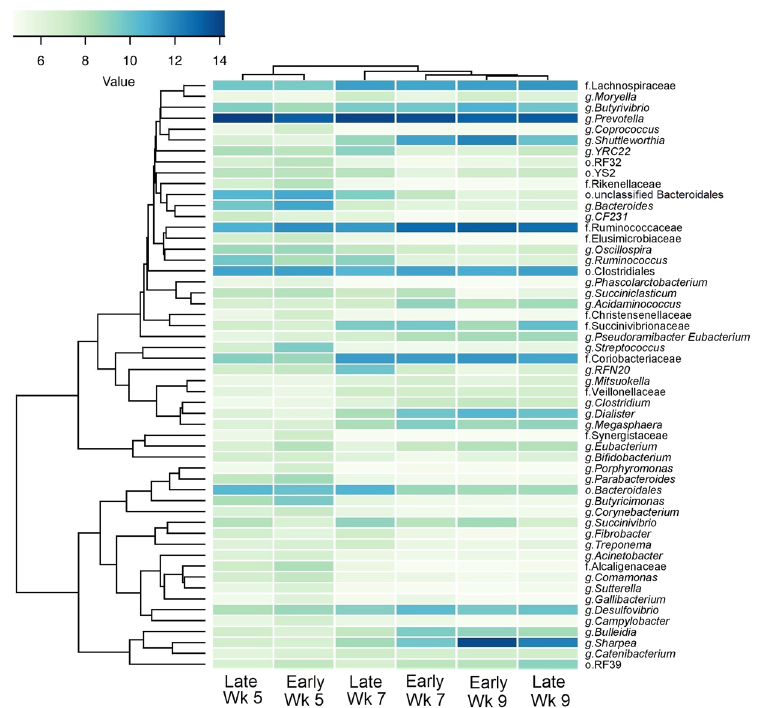
Figure 3. Correlation between ruminal microbiota and calf age and weaning strategy. The heatmap shows bacterial abundance in rumen varied with calf age (5, 7 and 9 weeks) and weaning age (6 vs. 8 weeks for early- and late-weaning, respectively). Data represent taxa present at greater than 1% of community that were significantly different (P < 0.05) between at least two ages or between treatment groups (weaning age). See Table S1 for additional data. The OTU count data was subjected to variance stabilizing transformation and summarised to calculate genus abundant data. Hierarchically clustering was then performed based on complete linkage of Euclidean distances matrix and visualized over heatmap using the heatmap.2 function of the “gplots” R